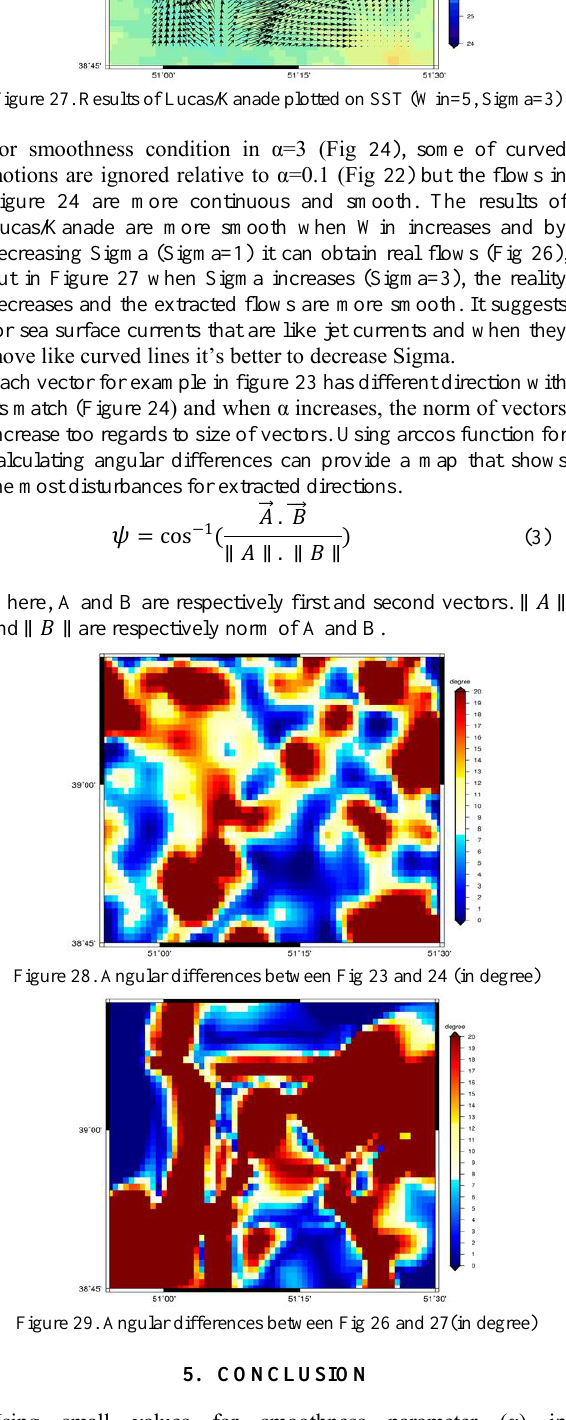
Figure 29. Angular differences between Fig 26 and 27(in